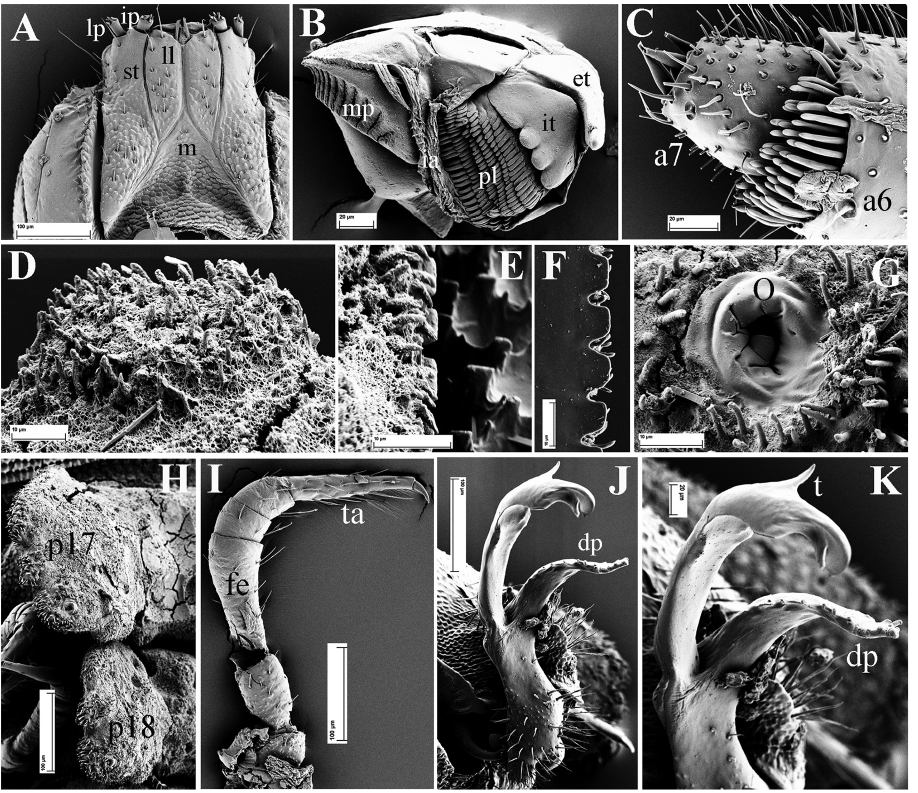
Figure 12. E. parvus sp. n., SEM, male paratype from Cave Tham Nam Long. A gnathochilarium, ven- tral view (lp = lateral palpus; ip = inner palpus; st = stipites; ll = lamellae linguales; m = mentum) B right mandible, general view (et = external tooth; it = internal tooth; pl = pectinate lamellae; ia = intermediate area; mp = molar plate) C tip of antenna, laterodorsal view (a6–a7 = antennomeres 6, 7) D a tubercle at fore margin of collum, dorsal view E limbus of metatergum 10, dorsal view F endotergum 9 G ozopore (o) on paratergum 17, general view H paratergum 17 (p17) and 18 (p18), lateral view I midbody leg, frontal view (fe = femur; ta = tarsus; cl = claw) J left gonopod, submesal view K half of left gonopod, detail (dp = distofemoral process; t =